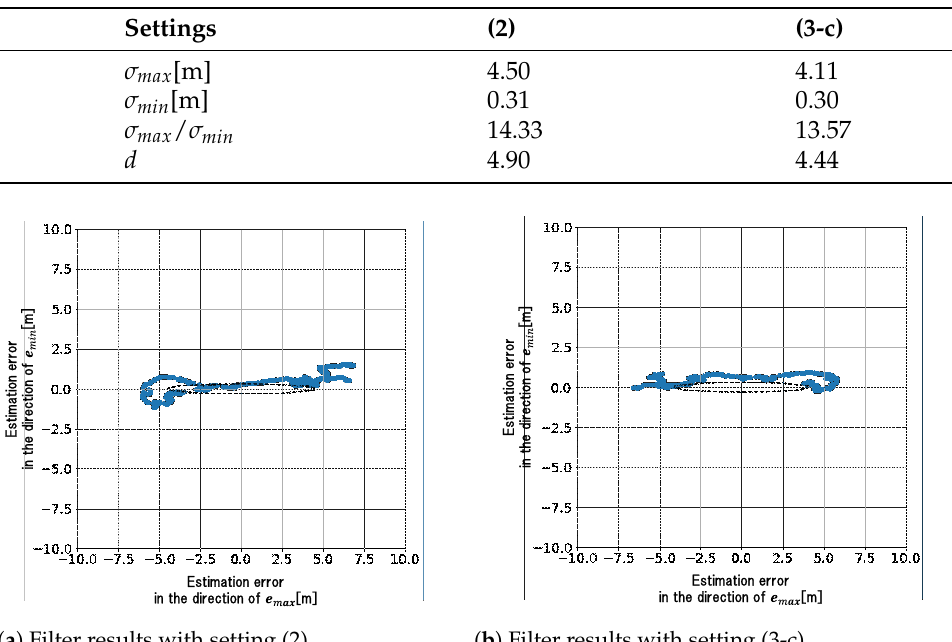
Figure 6. Estimated position errors in the plane spanned by e min and e max